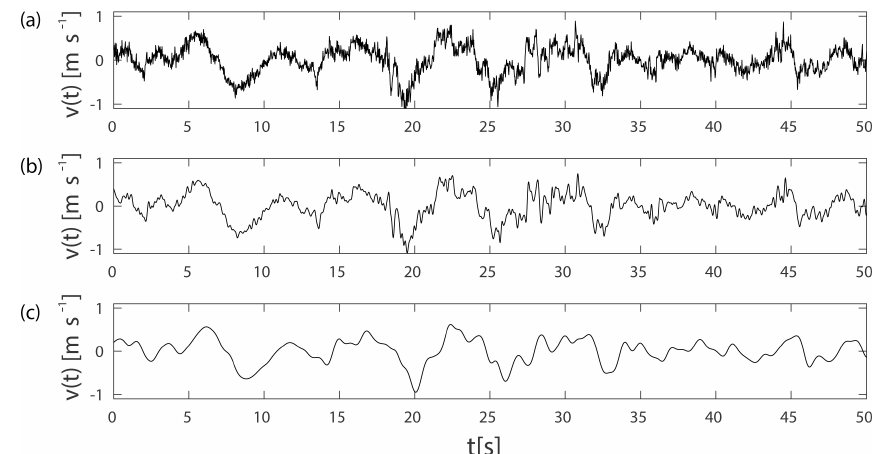
Figure 3. Measured velocity fluctuations: (a) unfiltered signal; (b) signal filtered with f cut = 5Hz; (c) signal filtered with f cut = 1Hz.